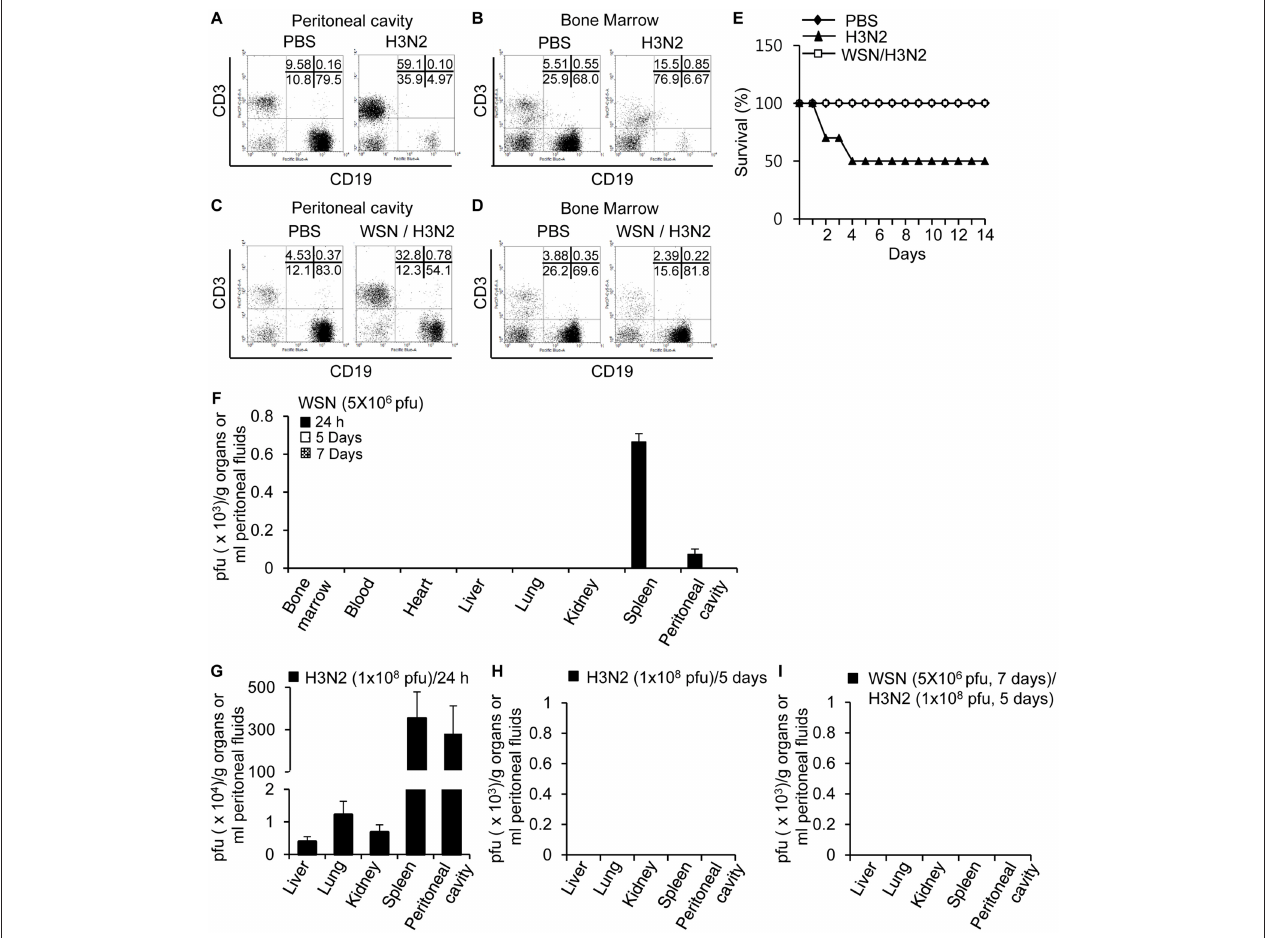
FIGURE 7 | Cross-protection of A/WSN/1933 virus inoculation against lethal dose of A/Hongkong/4801/2014 (H3N2) virus. (A,B) BALB/c mice ( n = 5) were sacrificed 5 days after a single intraperitoneal challenge with 1 × 10 8 pfu of wt A/Hong Kong/4801/2014 (H3N2) virus, and the populations of peritoneal cavity B cells (A) and bone marrow B cells (B) were analyzed by flow cytometry. (C,D) BALB/c mice ( n = 10) were first inoculated with A/WSN/1933 virus (5 × 10 6 pfu) and then inoculated with A/Hongkong/4801/2014 (H3N2) (1 × 10 8 pfu) after 7 days, followed by sacrifice 5 days after the second challenge. The B cell populations of the peritoneal cavity (C) and bone marrow (D) were characterized by flow cytometry. (E) BALB/c mice ( n = 10) were first inoculated with A/WSN/1933 virus (5 x 10 6 pfu), and a second inoculation with A/Hongkong/4801/2014 (H3N2) (1 × 10 8 pfu) was performed after 7 days. The mice were monitored for 14 days, and survival percentages of the mice were measured. (F) BALB/c mice were infected intraperitoneally with 5 × 10 6 pfu of A/WSN/1933 virus ( n = 5/group). After 24h, 5 days and 14 days, A/WSN/1933 virus titers in the indicated organs (pfu/g), blood and peritoneal fluids (pfu/ml) were determined by plaque assay. (G,H) BALB/c mice were infected intraperitoneally with 1 x 10 8 pfu of A/Hongkong/4801/2014 (H3N2) virus ( n = 15/group). After 24h ( n = 5), virus titers in the indicated organs (pfu/g) and peritoneal fluids (pfu/ml) were determined by plaque assay (G) . After 5 days, virus titers in the indicated organs (pfu/g) and peritoneal fluids (pfu/ml) of A/Hongkong/4801/2014 (H3N2) virus-infected mice (live mice, n = 5) were determined by plaque assay (H) . (I) BALB/c mice ( n = 5) were first intraperitoneally inoculated with A/WSN/1933 virus (5 × 10 6 pfu), and a second inoculation with A/Hongkong/4801/2014 (H3N2) (1 × 10 8 pfu) was performed after 7 days. After another 5 days, virus titers in the indicated organs (pfu/g) and peritoneal fluids (pfu/ml) were determined by plaque assay. WSN, A/WSN/1933 virus. H3N2, A/Hongkong/4801/2014 (H3N2)